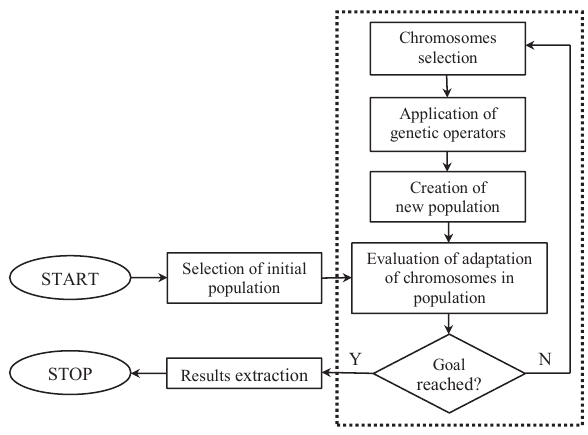
Figure 2. Genetic Algorithm operation diagram. Figure 2: Genetic Algorithm operation diagram.